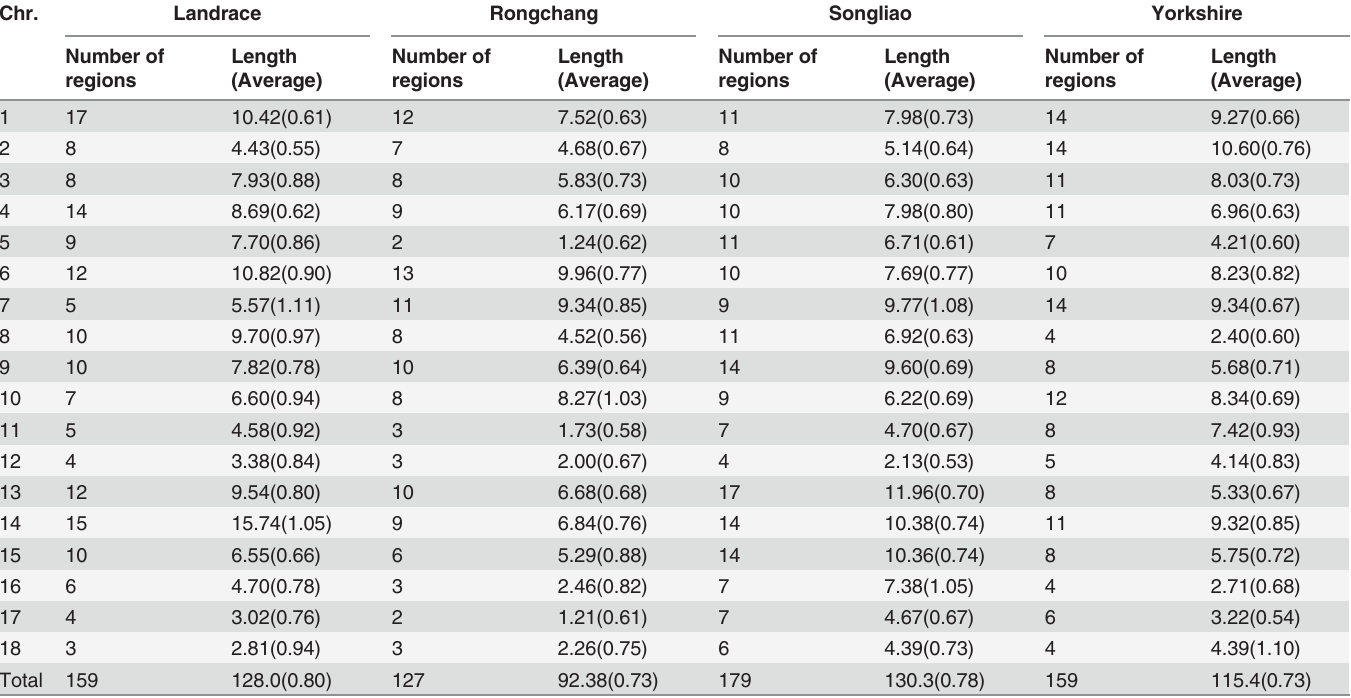
Table 3. Summary of whole genome candidate selection regions